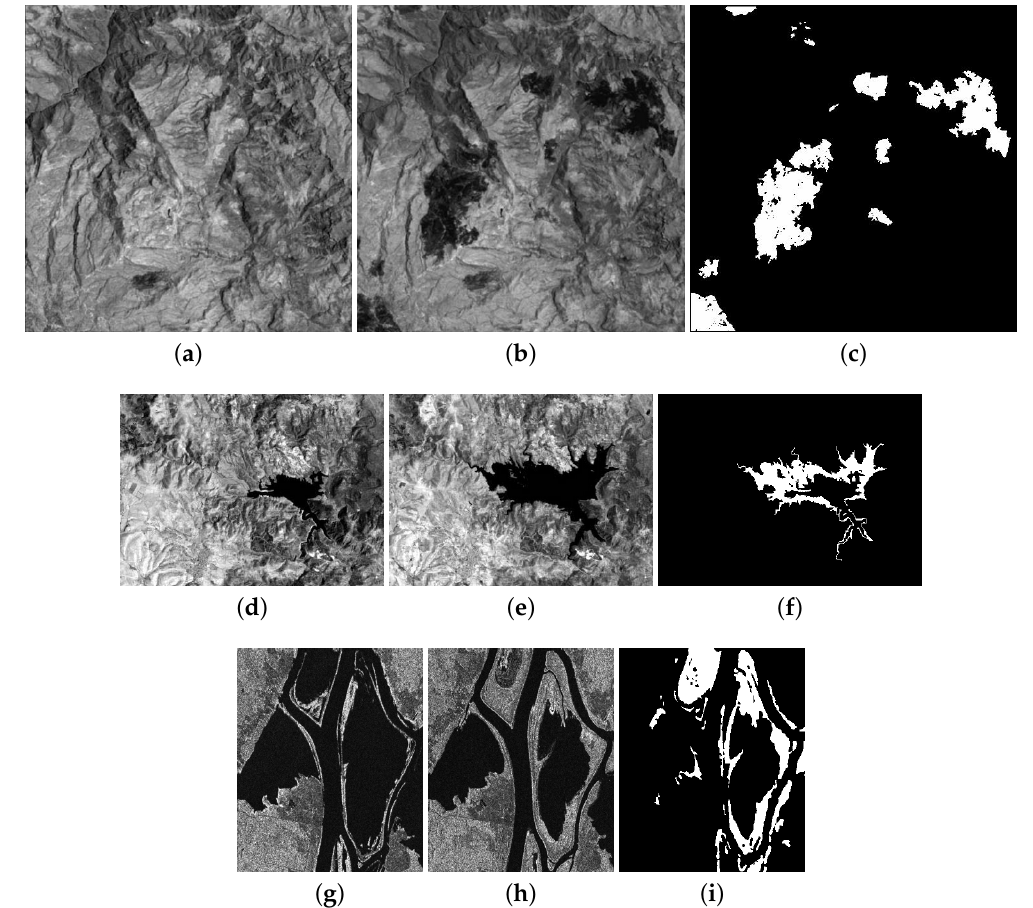
Figure 2. Image datasets and reference change maps. Mexico dataset: ( a ) April 2000 (band 4), ( b ) May 2002 (band 4); Sardinia dataset: ( d ) September 1995 (band 4), ( e ) July 1996 (band 4); Ottawa dataset: ( g ) July 1997, ( h ) August 1997; ( c , f , i ): the reference change map for Mexico dataset, Sardinia dataset, Ottawa dataset,